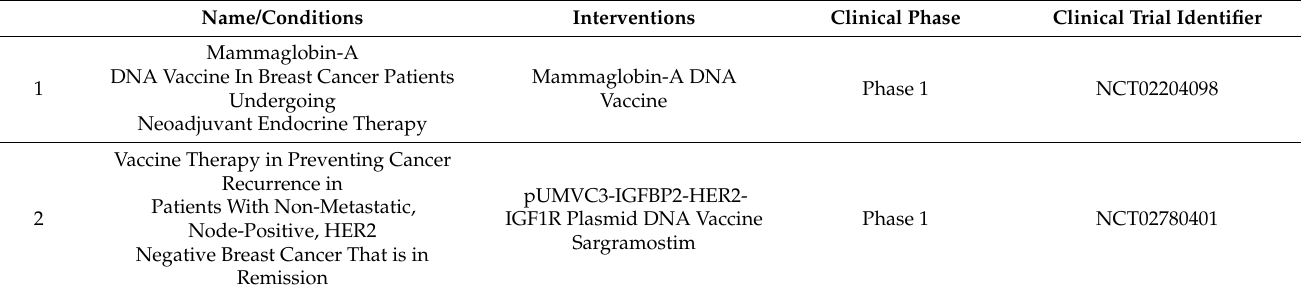
Table 3. List of various cancer vaccines currently under clinical trials